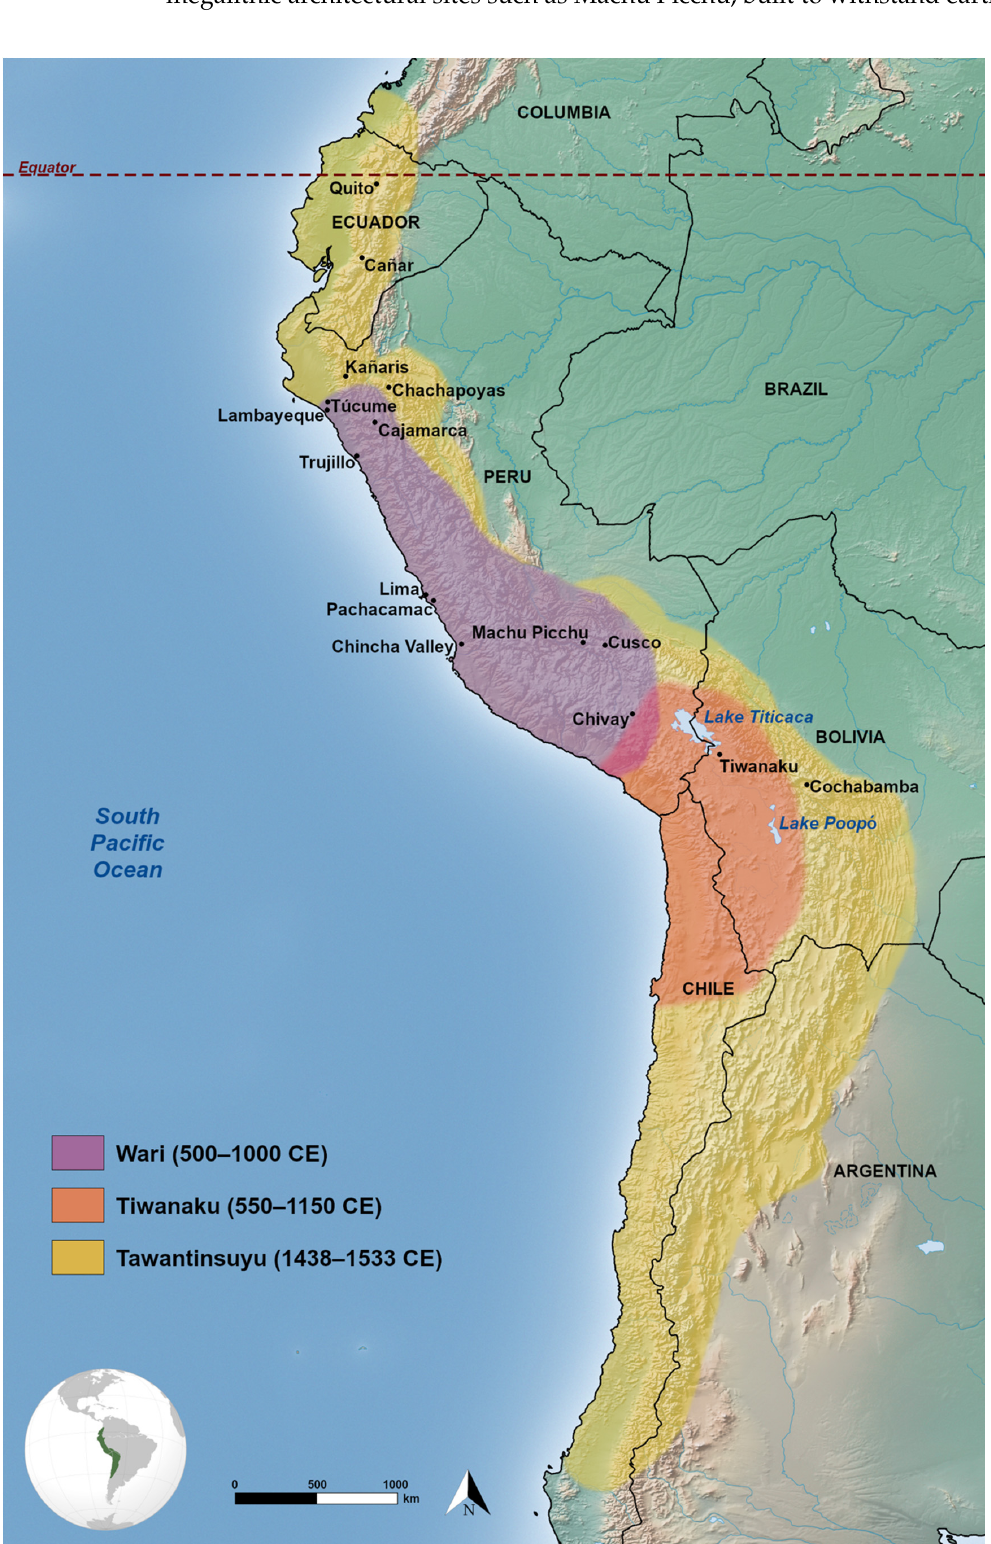
Figure 1. Political regions in the Andes. The Tiwanaku sphere (orange) and Wari sphere (purple) are overlayed with the maximal range of Tawantinsuyu (yellow). Locations mentioned in the text are also shown. Globe inset shows the location of Tawantinsuyu in the American continents. Made with Natural Earth.